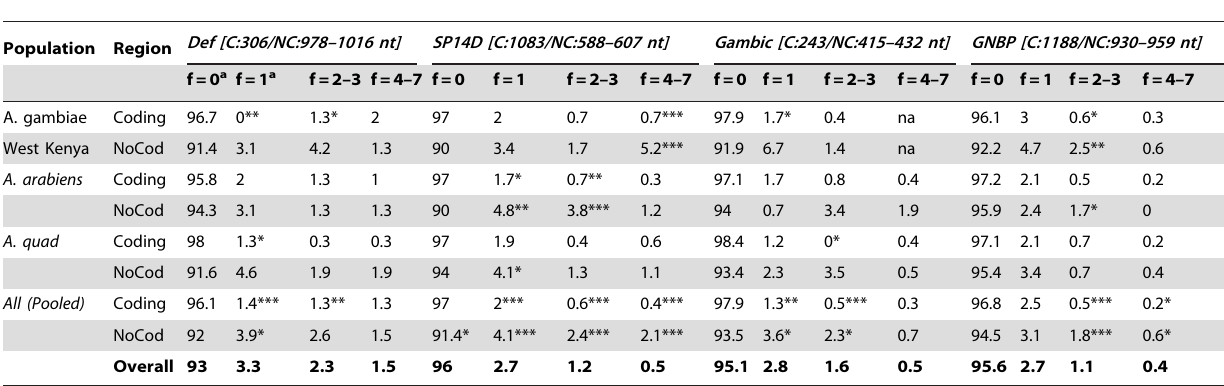
Table 4. Frequency spectra in coding (C) and non-coding (NC) regions across species at each gene.